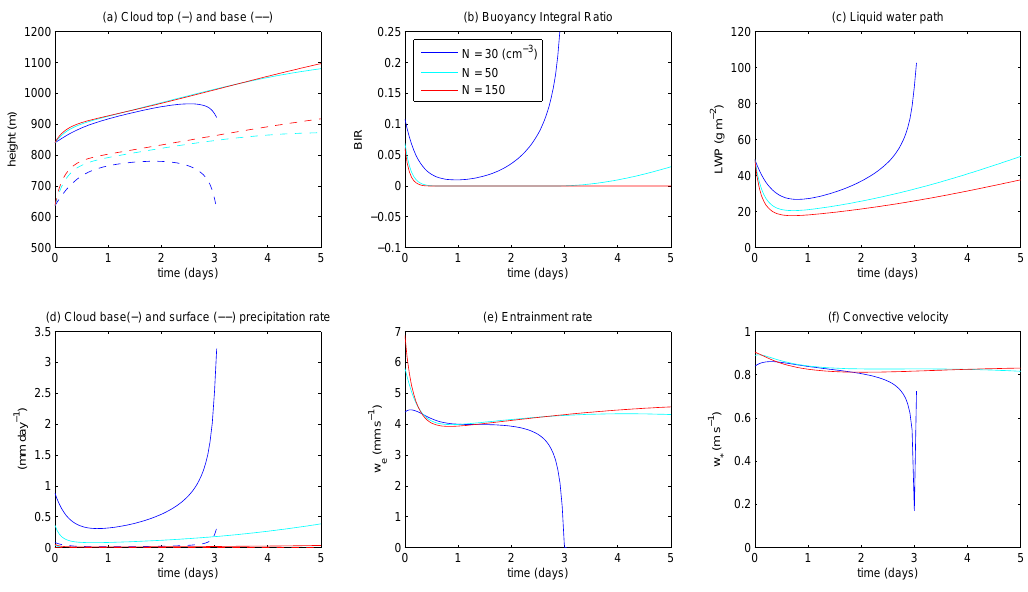
Fig. 5. As in Fig. 3, but using a 2 =110 in the MLM entrainment closure.